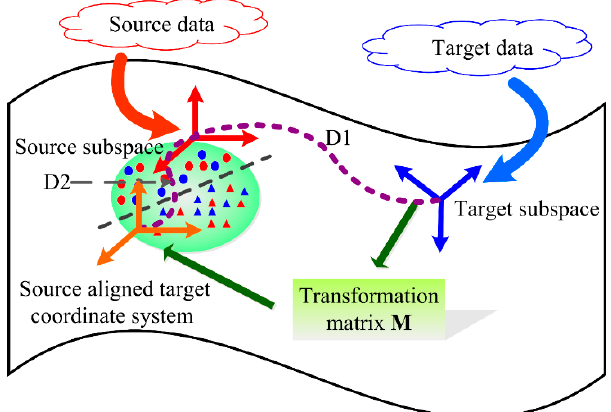
Figure 4. Schematic diagram of the target subspace aligned to the source subspace (Note: Source domain is represented by the source subspace S S and target domain is represented by the target subspace S T . Then the target subspace is aligned to the source subspace by M , which makes the target subspace close to the source space in the Bregman divergence perspective (i.e., D2 < D1). Then the source data is projected to the source subspace and the target data is projected to the source-aligned target subspace. As well, the prediction model trained by projected source data can be used to the projected target